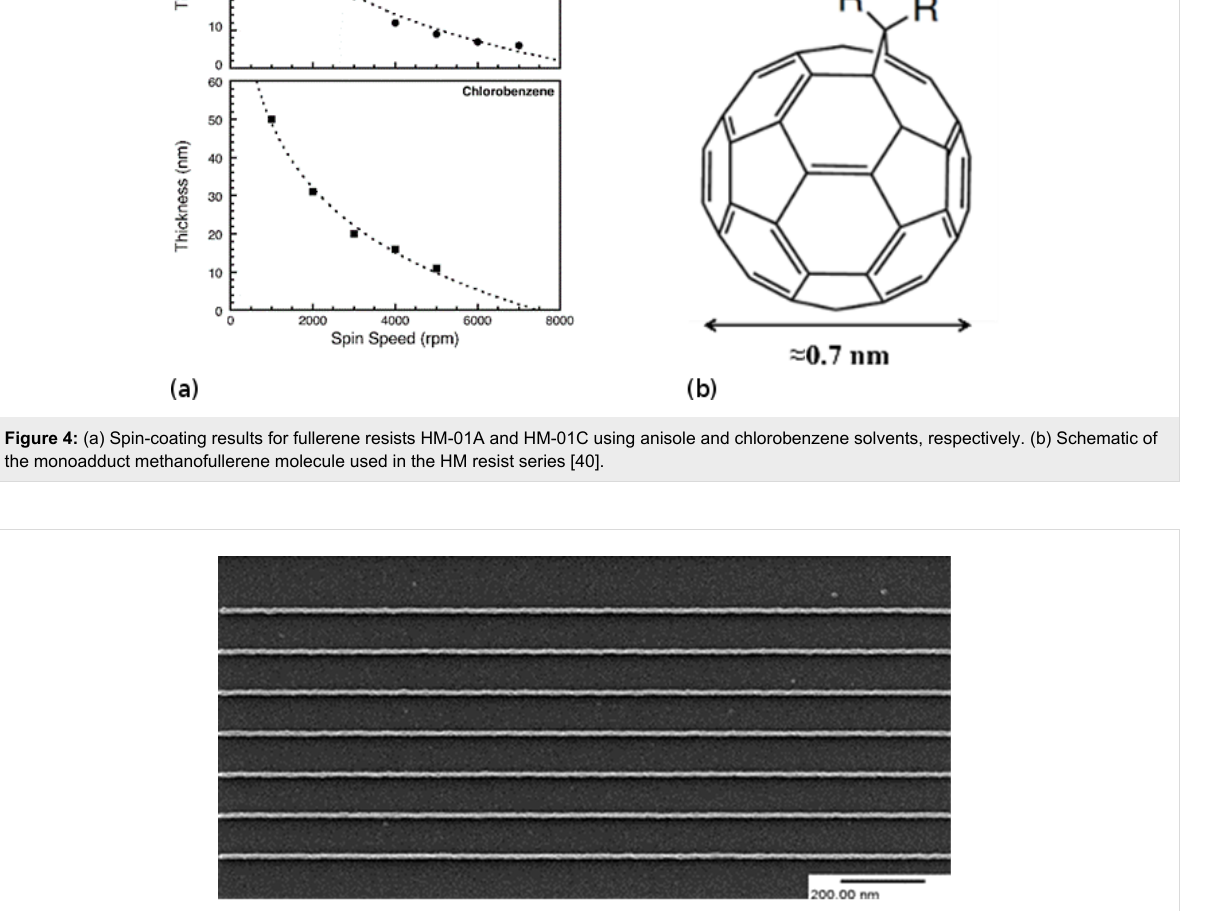
A comparison of the sensitivity of the HM resists for He + ion beam lithography at a beam energy of 30 keV and that for